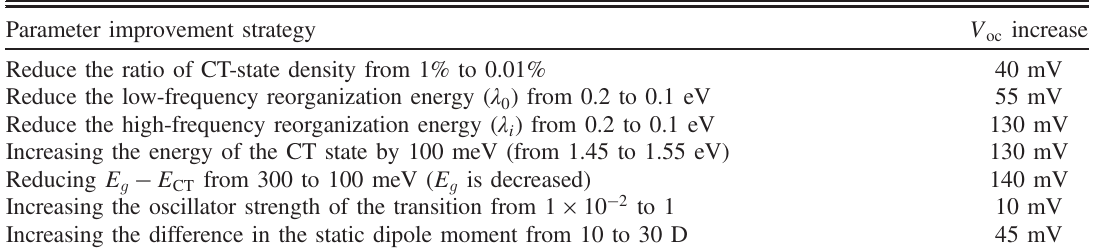
TABLE II. Potential open-circuit voltage increase when changing different parameters in the range shown. Parameter improvement